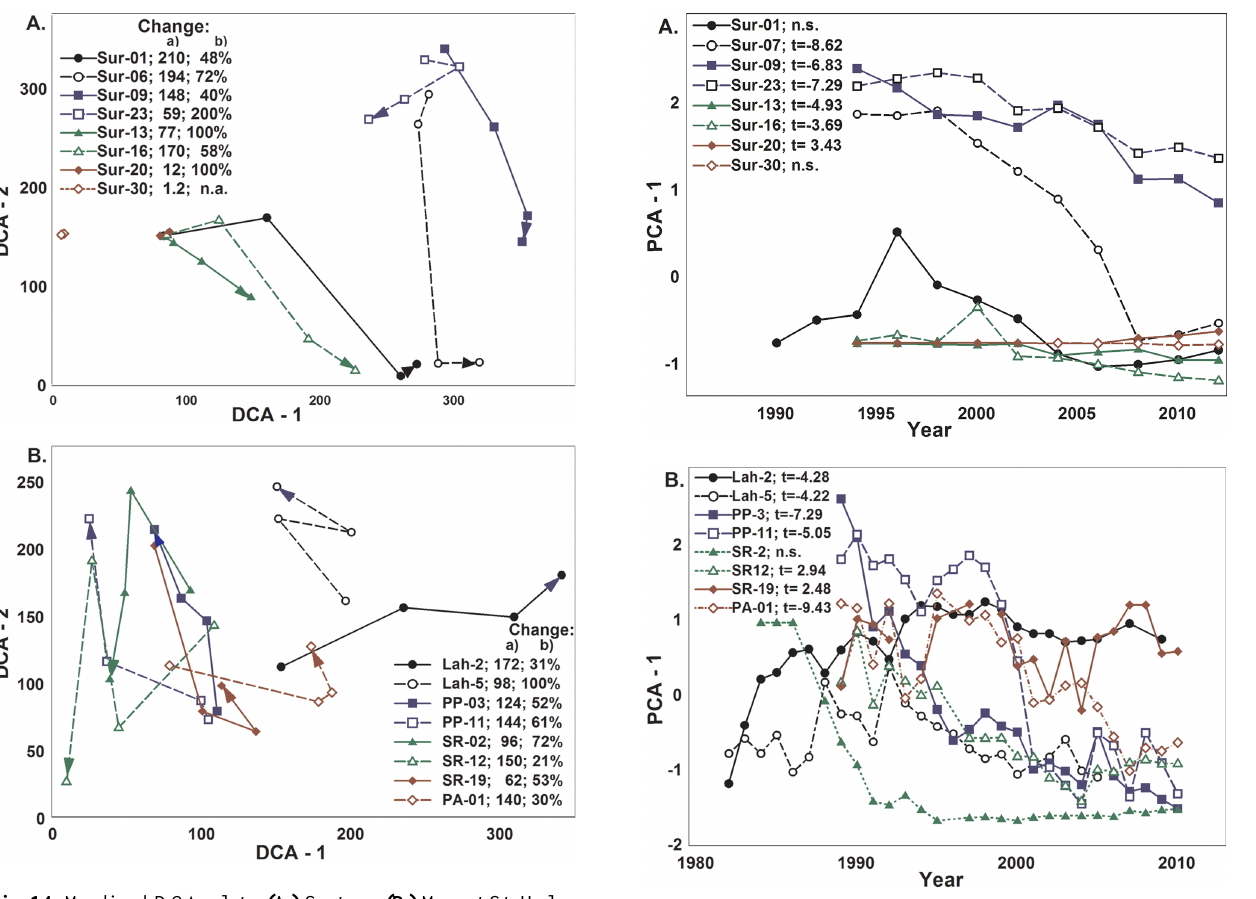
Fig. 15. The first principal component of the DCA scores over time. (A) Surtsey; (B) Mount St. Helens. The t value derives from a linear regression of the PCA 1 axis over